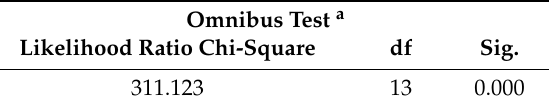
Table A4. Likelihood Ratio Chi-Square